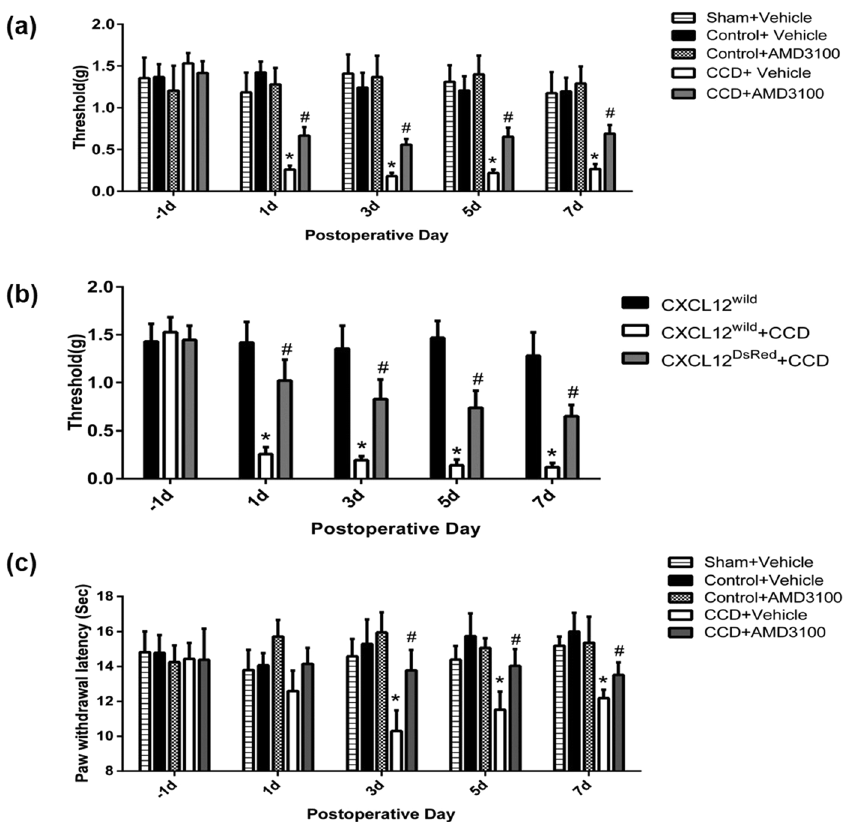
Figure 6. Effects of CXCR4 blockade and CXCL12 deficiency on behavioral postoperative mechanical threshold. Threshold was defined as the force eliciting 50% paw withdrawal. ( a ) The postoperative mechanical thresholds of CCD mice (n = 10) were significantly reduced on postoperative day 1 and remained decreased through day 7, and intraperitoneal injection of AMD3100 ameliorated the tactile allodynia (n = 10) but had no such effects in control mice (n = 6). No obvious mechanical hyperalgesia was observed after sham operation and there were no differences in mechanical threshold between sham (n = 6) and naïve control. * P < 0.05 vs. (control + vehicle) group (n = 10), # P < 0.05 vs. (CCD + vehicle) group, LSD post hoc test following two- way ANOVA with repeated measures. ( b ) After CCD surgery, the CXCL12 DsRed knock-in mice (n = 9) with deficient function of CXCL12 showed higher postoperative mechanical thresholds than CXCL12 wild + CCD group. * P < 0.05 vs. CXCL12 wild group (n = 5), # P < 0.05 vs. (CXCL12 wild + CCD) group (n = 7), LSD post hoc test following two-way ANOVA with repeated measures. ( c ) Thermal latencies of CCD mice (n = 7) were significantly reduced on postoperative day 3 and remained decreased through day 7, and intraperitoneal injection of AMD3100 ameliorated the thermal hyperalgesia (n = 8) in CCD mice but not in control mice (n = 6). * P < 0.05 vs. (control + vehicle) group (n = 10), # P < 0.05 vs. (CCD + vehicle) group, LSD post hoc test following two-way ANOVA with repeated